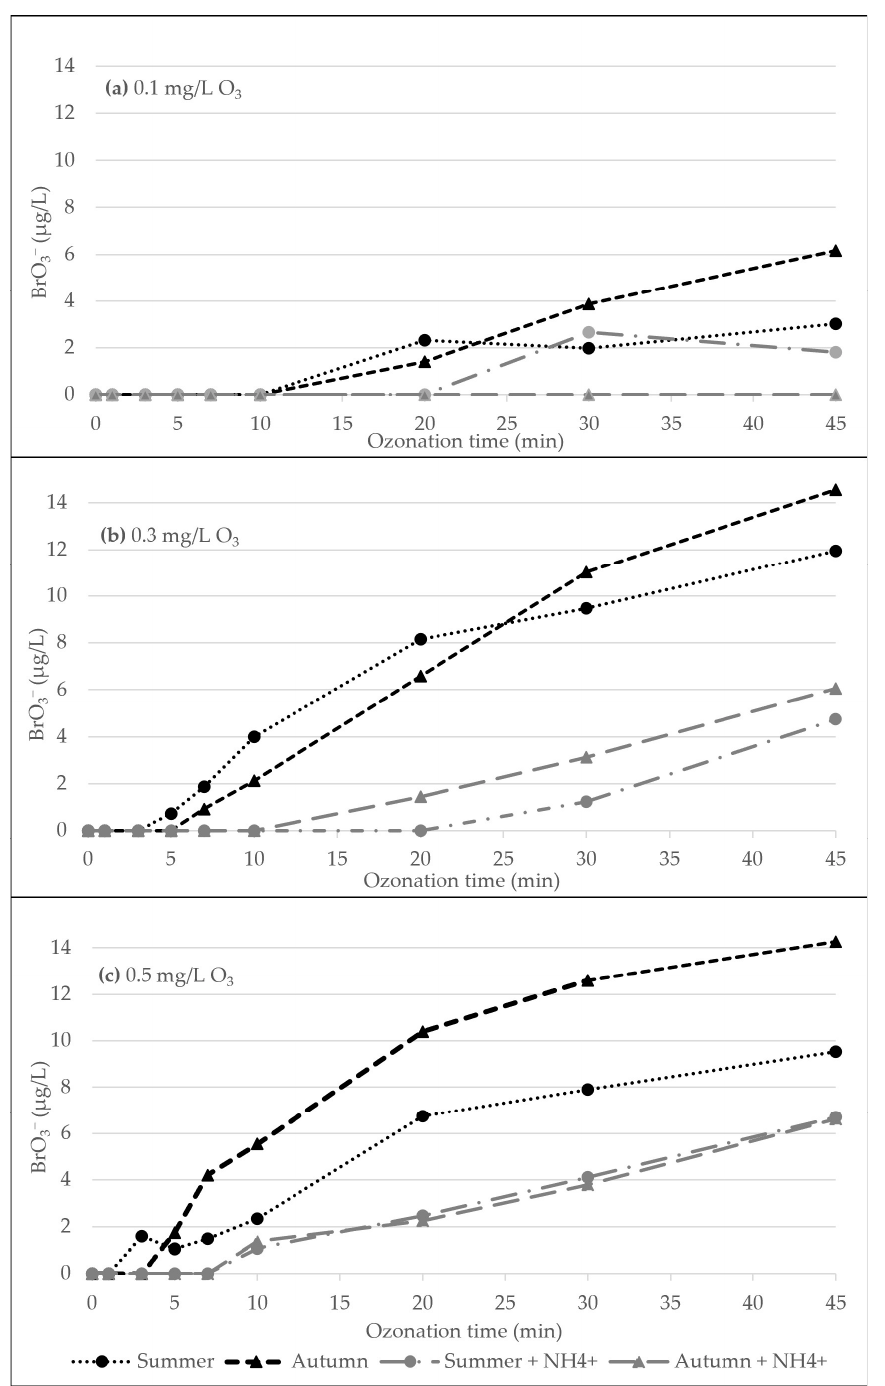
Figure 1. Formation of bromate both with and without NH 4+ addition at the ozone dosages of ( a ) 0.1 mg/L, ( b ) 0.3 mg/L, and ( c ) 0.5 mg/L.